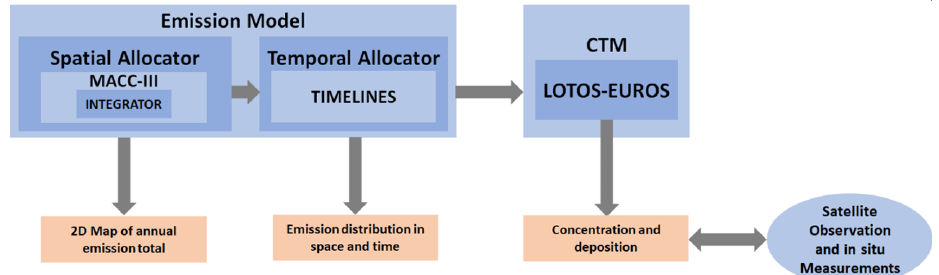
Figure 1. A simplified scheme of the workflow in this project, involving the development of spatial and temporal allocators of the emission model and the verification with measurement